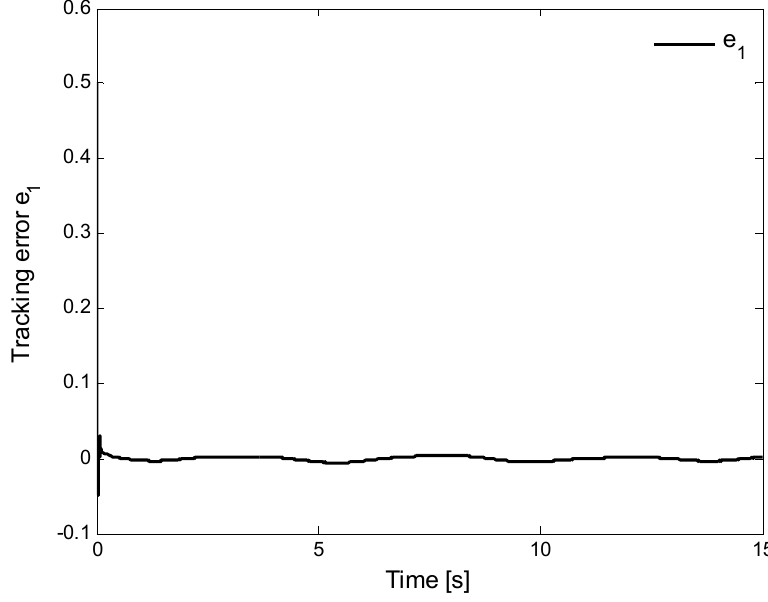
Figure 2. Trajectories of system output and desired signal x 1